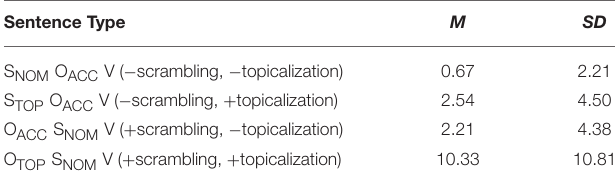
TABLE 1 | Error rates (%) for target sentences.